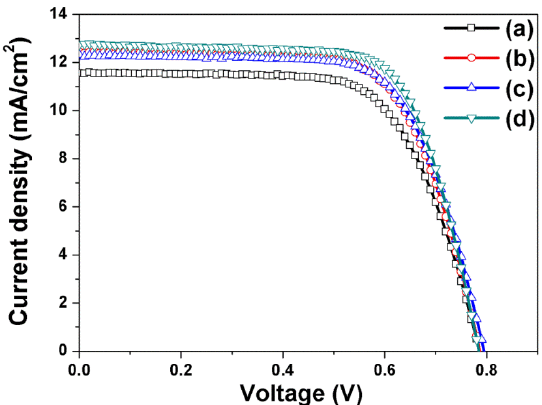
Figure 5. I–V curves of DSSCs based on open-ended freestanding TiO 2 nanotube arrays fabricated without NPs ( a ), with Ag NPs ( b ), with large TiO 2 NPs ( c ), and with both Ag NPs and large TiO 2 NPs ( d ).